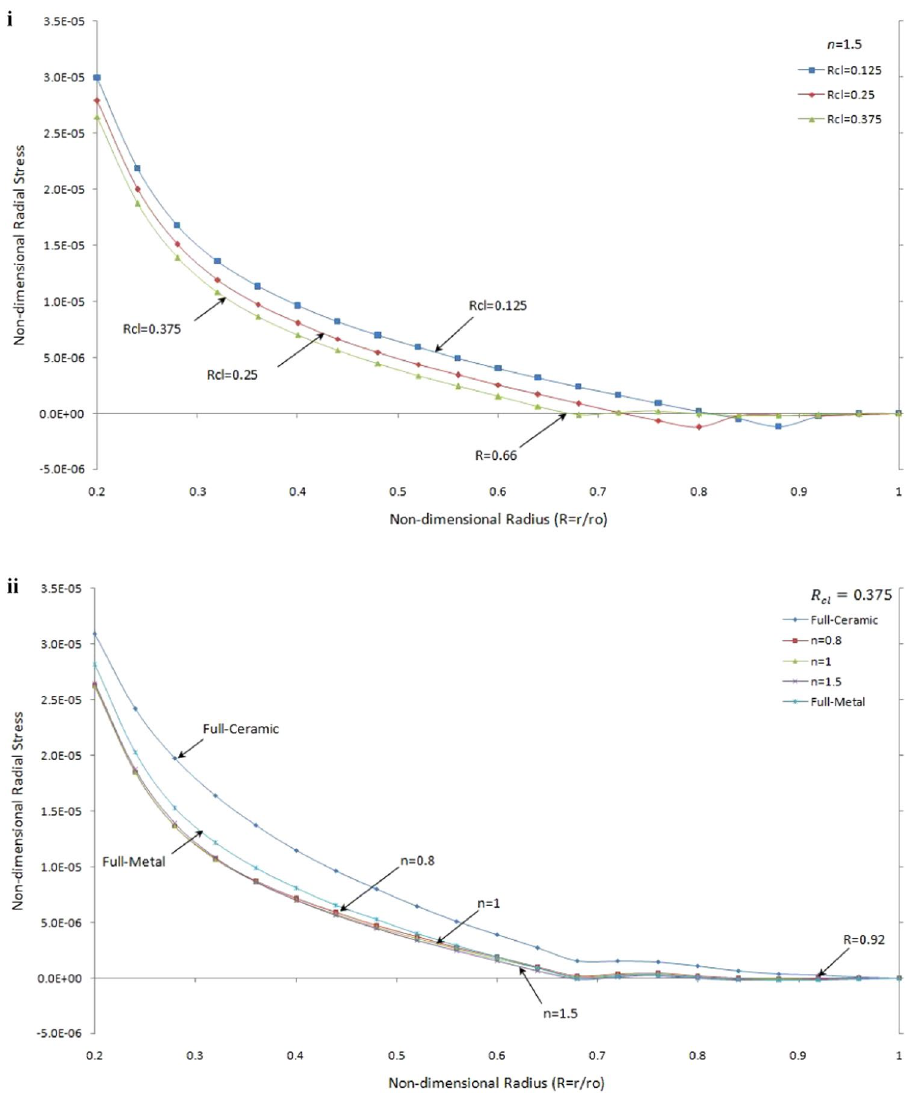
Figure 6. Non-dimensional radial stress versus the non-dimensional radius of one side contact with thermo- mechanical load (i) in the FGMs rotating brake disk with different R cl and n = 1.5 (ii) in the rotating brake disk with R cl = 0.375 and different values of the grading index